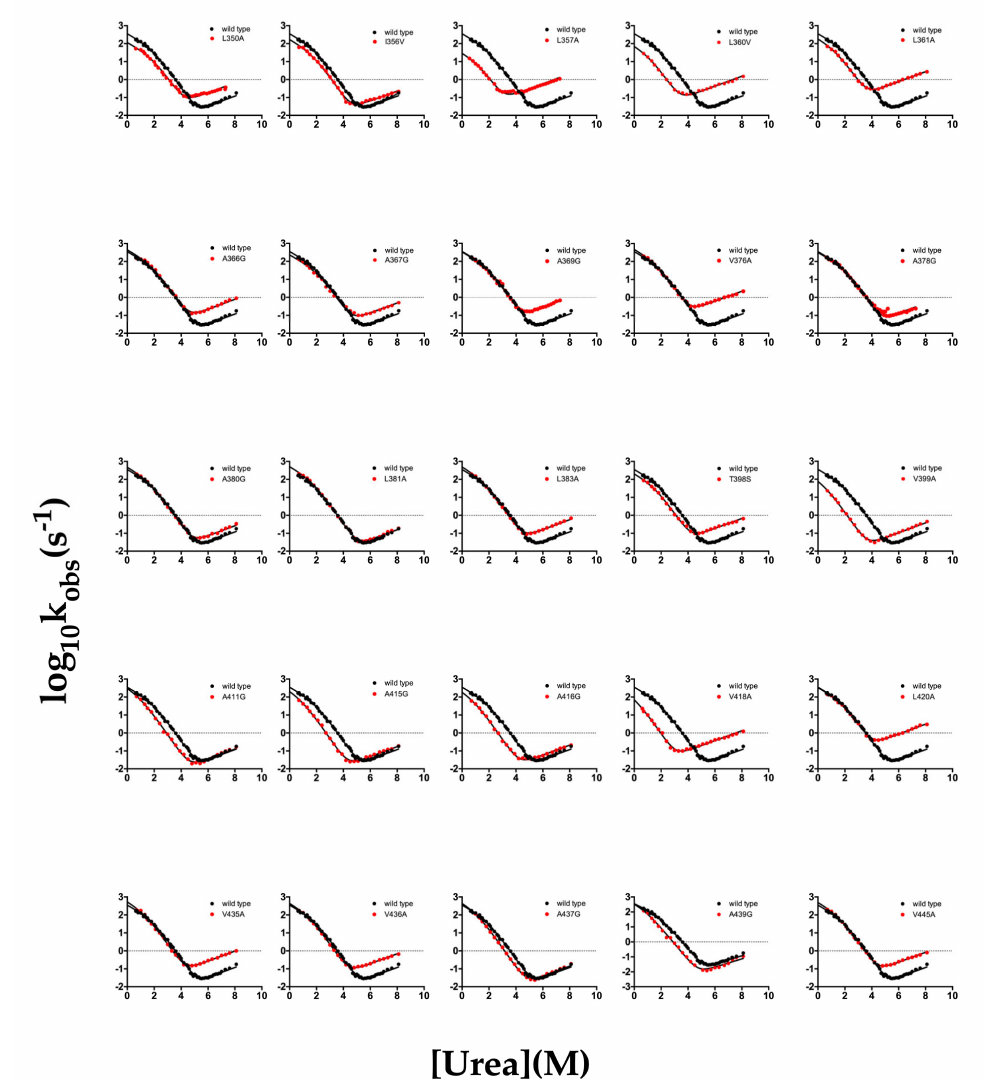
Figure 2. Chevron plots of BRD2(2) and its mutants. In the different panels the chevron plots of BRD2(2) wild type (in black) and its mutants (in red) are shown. All of the experiments were carried out in 50 mM of Tris HCl, pH = 7.5, 0.2 M of NaCl, and 2 mM of DTT. The data were globally fitted to a three-state folding mechanism, sharing the